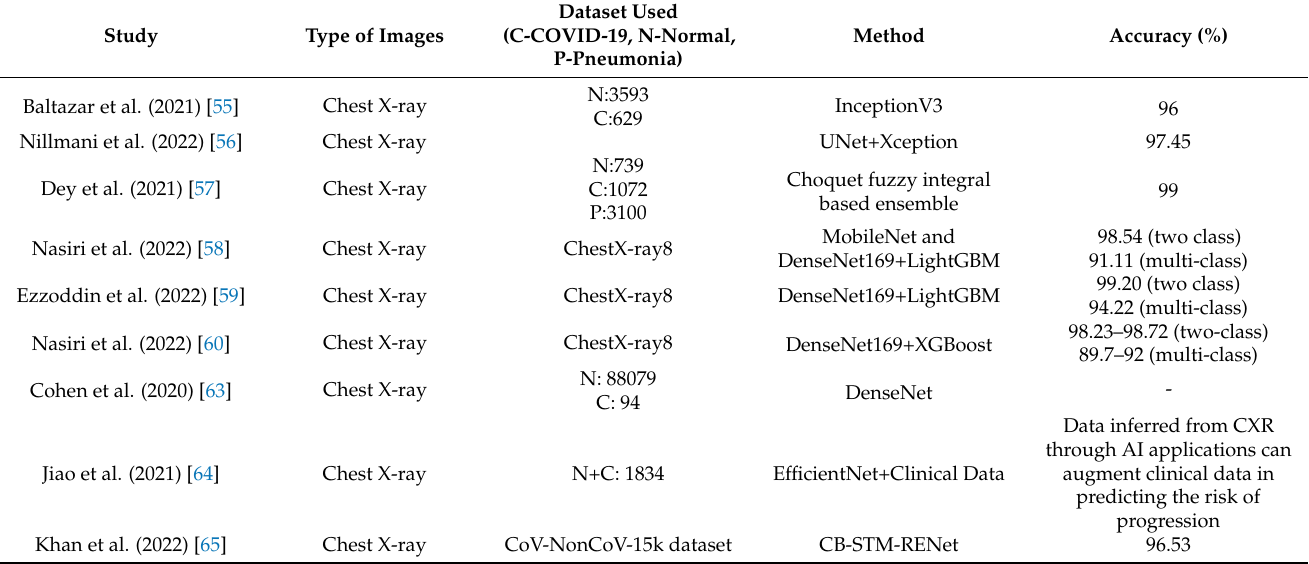
Table 2. Accuracy of most recent studies for COVID-19 diagnosis using artificial intelligence and